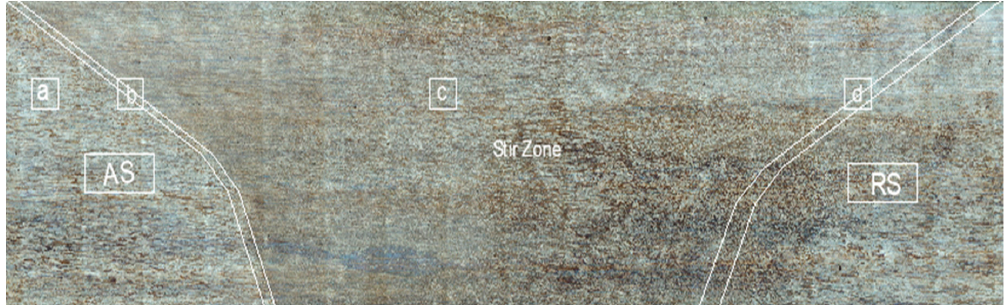
Figure 8. Microstructural image of 2507 SDSS after FSP, from the base metal (BM) ( a ), to the thermo- mechanically affected zone (TMAZ) on the advancing side (AS) ( b ), to the SZ ( c ), and to TMAZ on the retreating side (RS) ( d ).